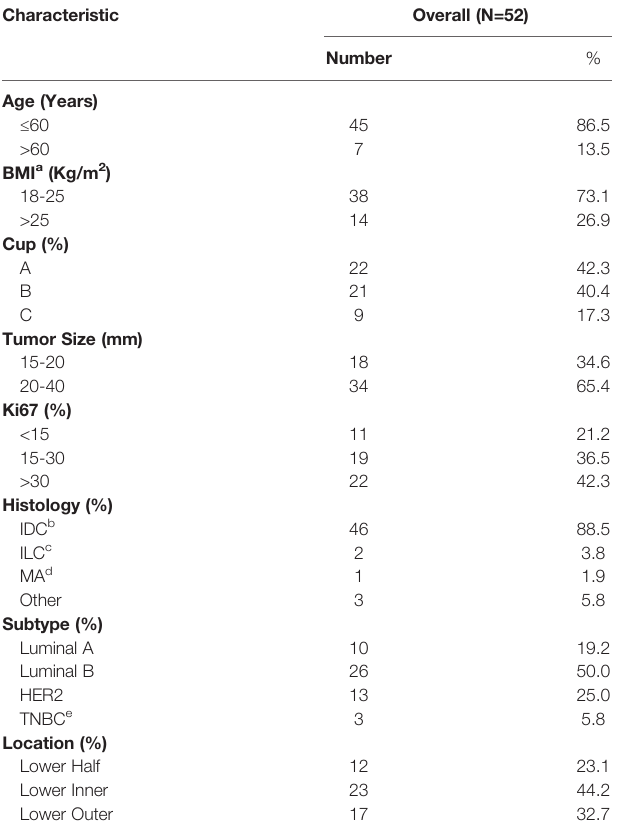
TABLE 1 | Baseline characteristic of enrolled patients.